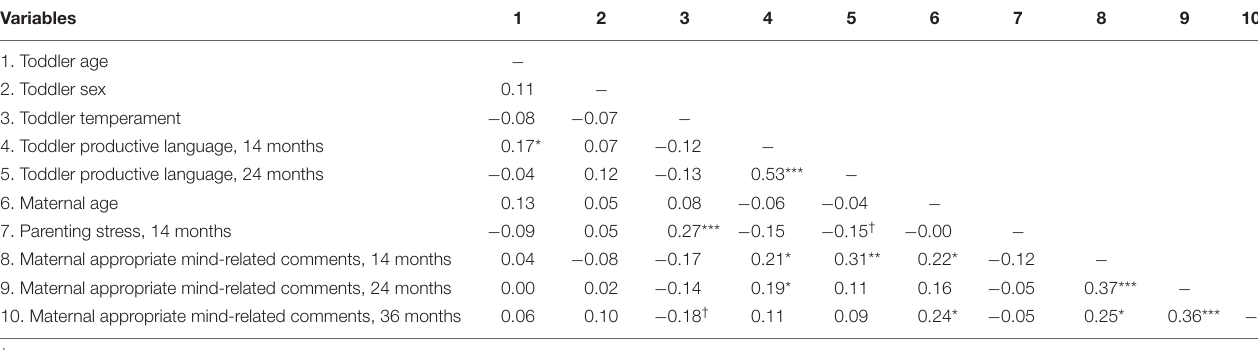
TABLE 2 | Correlations among study variables.